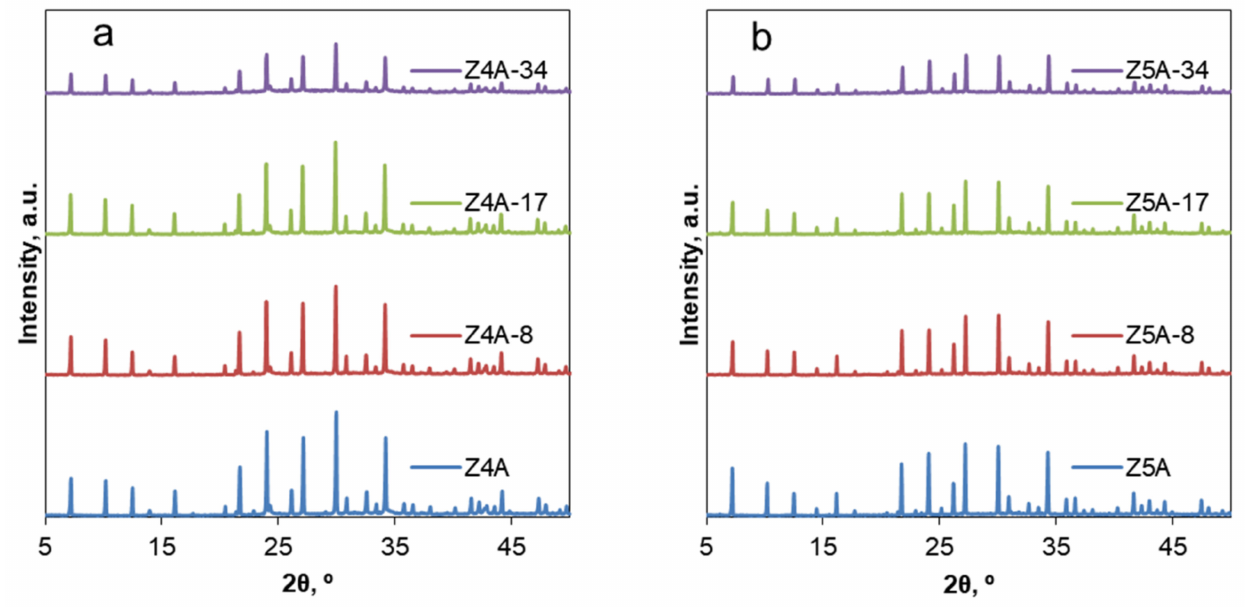
Figure 1. XRD patterns of the parent and EDTA dealuminated zeolite 4A ( a ) and zeolite 5A ( b )